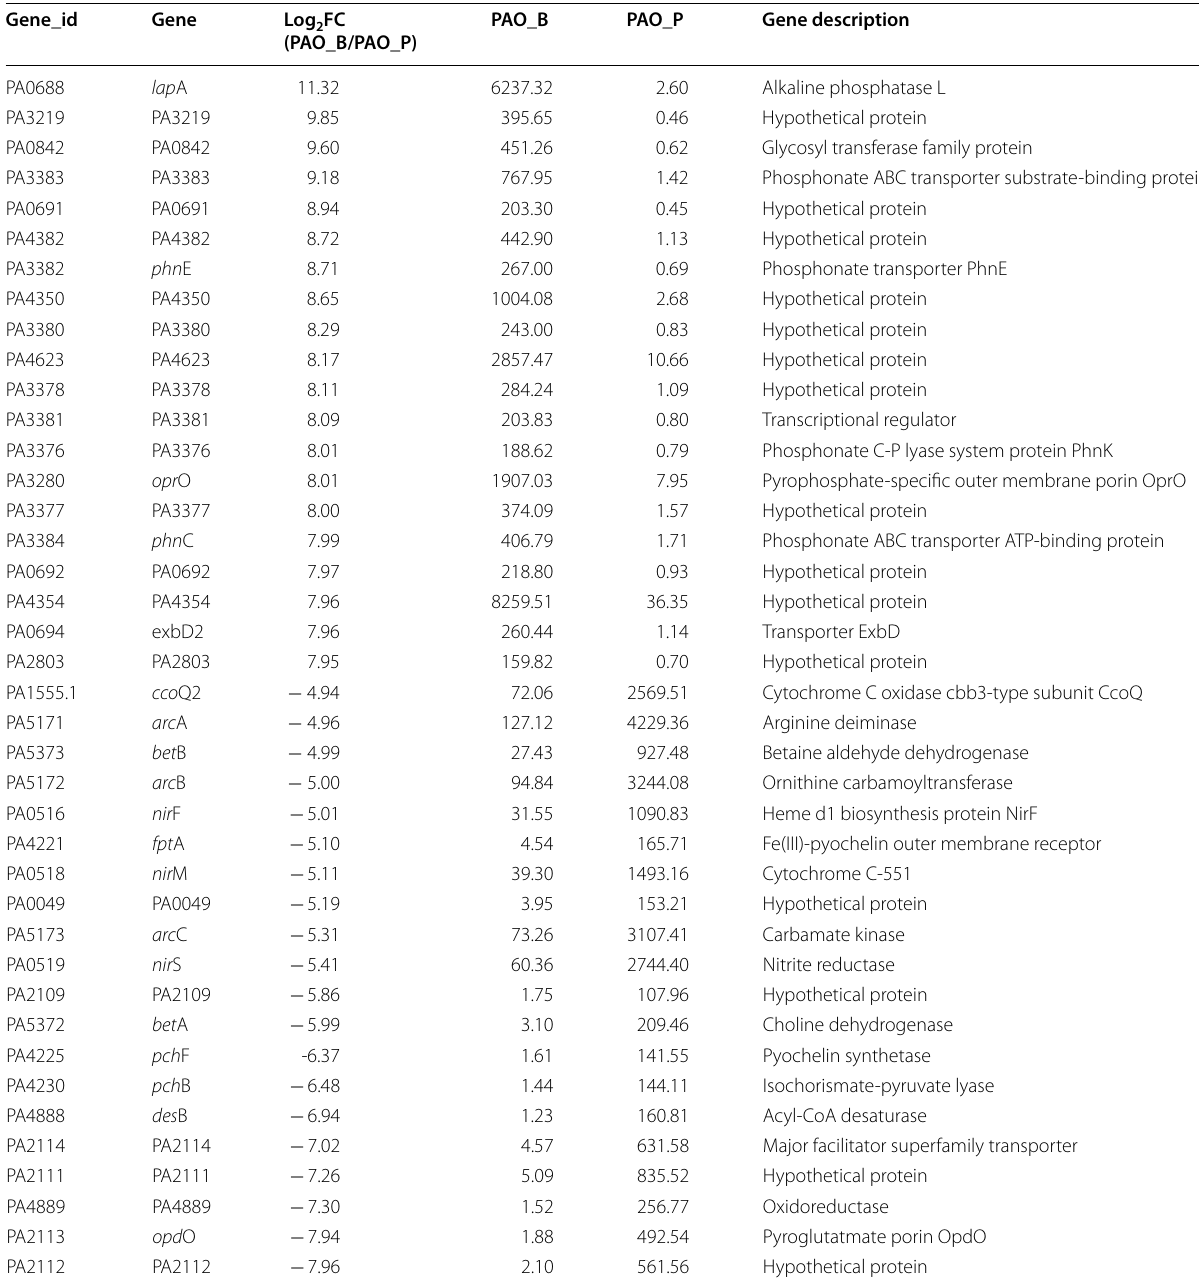
Table 1 The top 20 up- and down-regulated genes in biofilm samples,